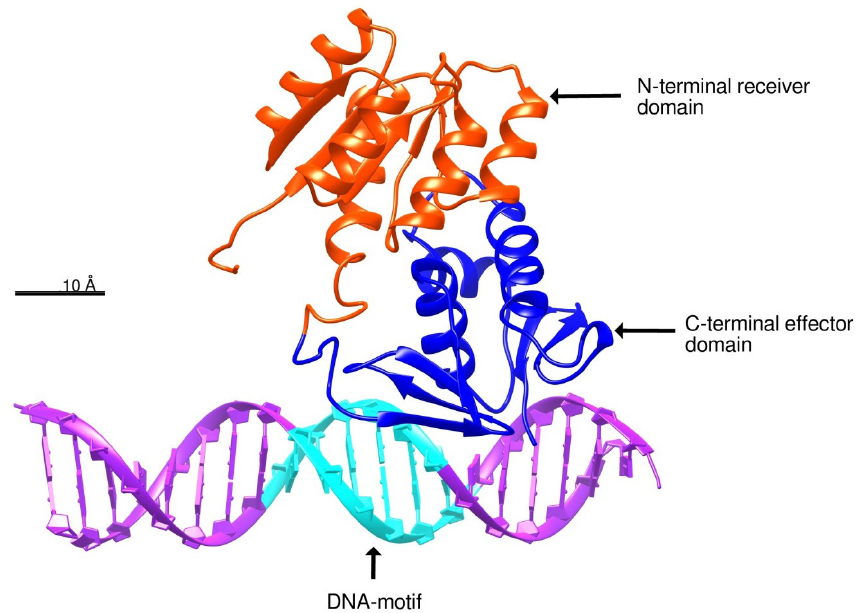
Figure 4. Docking prediction between BvrR and DNA. The docked pose showed the interaction between the C -terminal effector domain of BvrR (blue) and the DNA-motif (cyan). The docking analysis was performed with HDOCK software. The protein was represented schematically with Chimera software developed by The National Institutes of Health (NIH) [31].